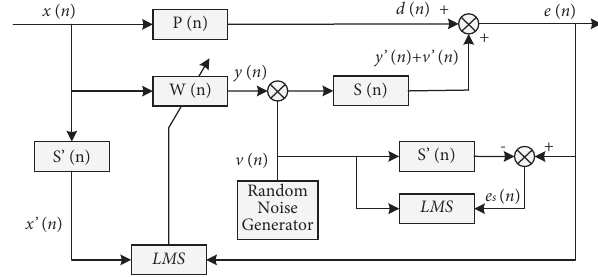
Figure 6: Eriksson’s secondary channel flow